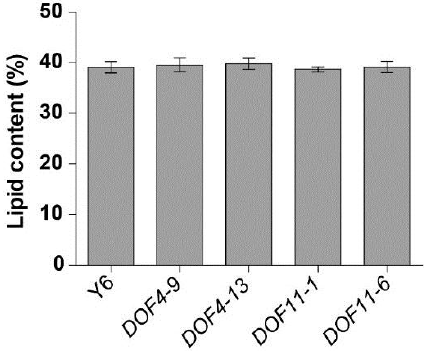
Figure 3. Total lipid contents in the seeds of GmDof4 and GmDof11 transgenic plants. The data represent the means ± SD of three replicate experiments and were analyzed by Student’s t -test ( n = 3).